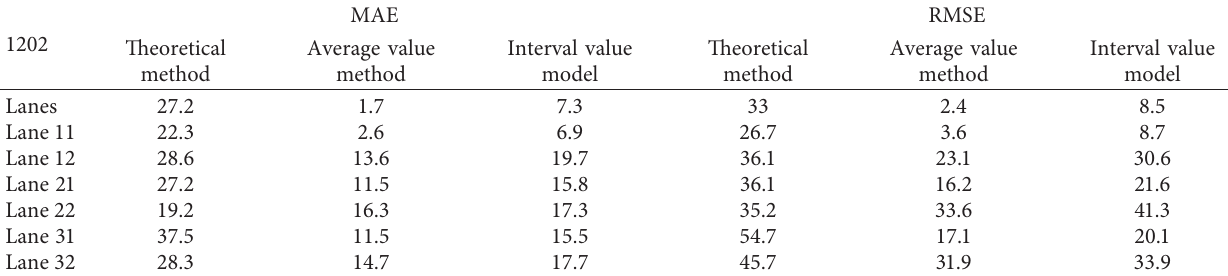
Figure 14: Typical vehicle location in the lane vehicle platoon on December 2, 2015: (a) lane condition, (b) lane 11 case, (c) lane 21 case, and (d) lane 32 case. Table 4: Data fitting accuracy by MAE and RMSE on December 2, 2015.